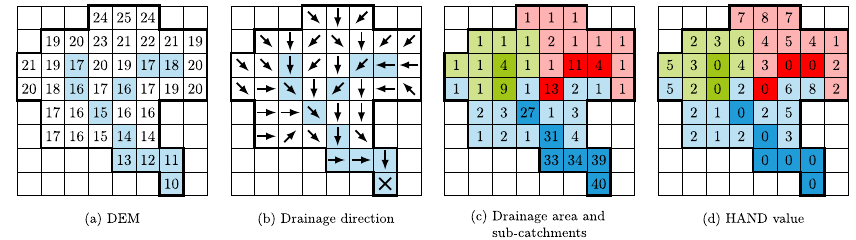
Figure 1. Processing of DEM and calculation of the HAND value for a hypothetical catchment.